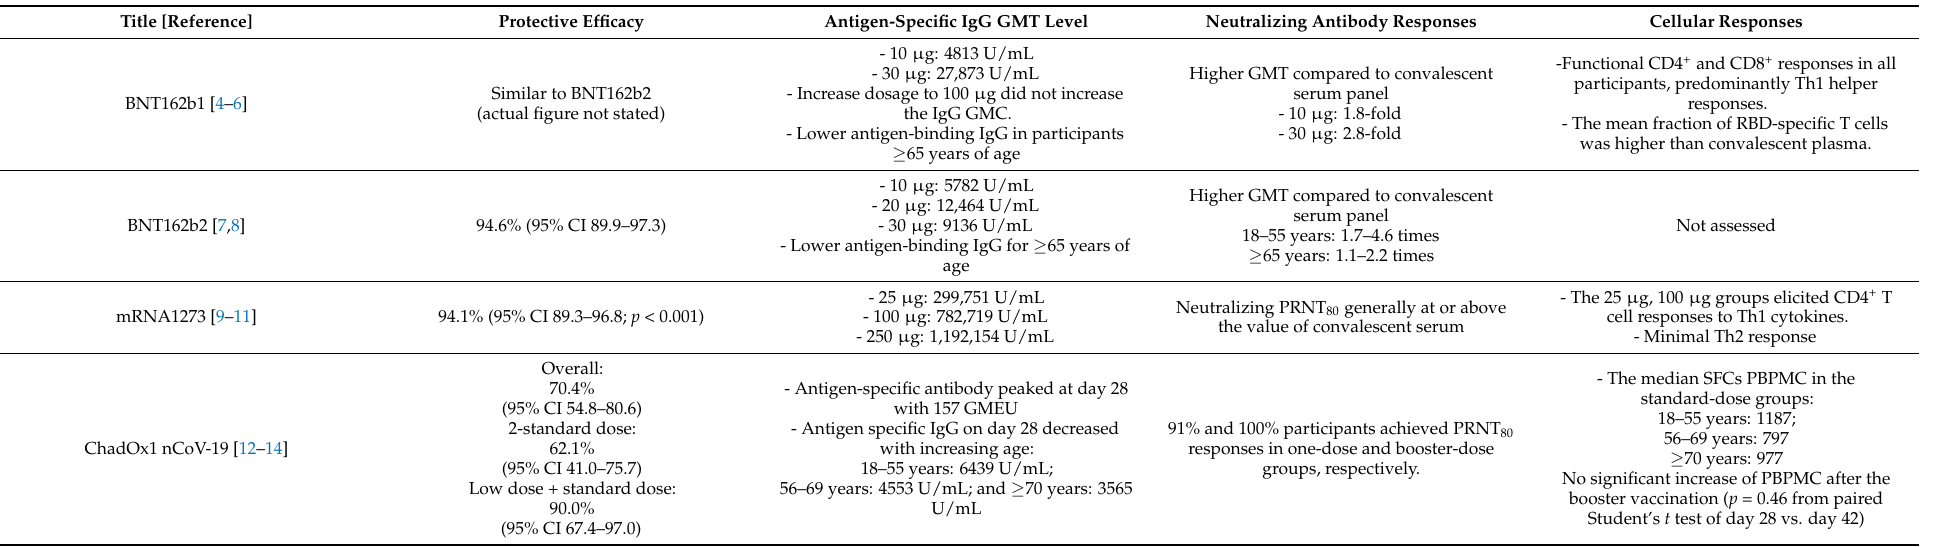
Table 2. Efficacy and other immune responses of vaccines after completion of